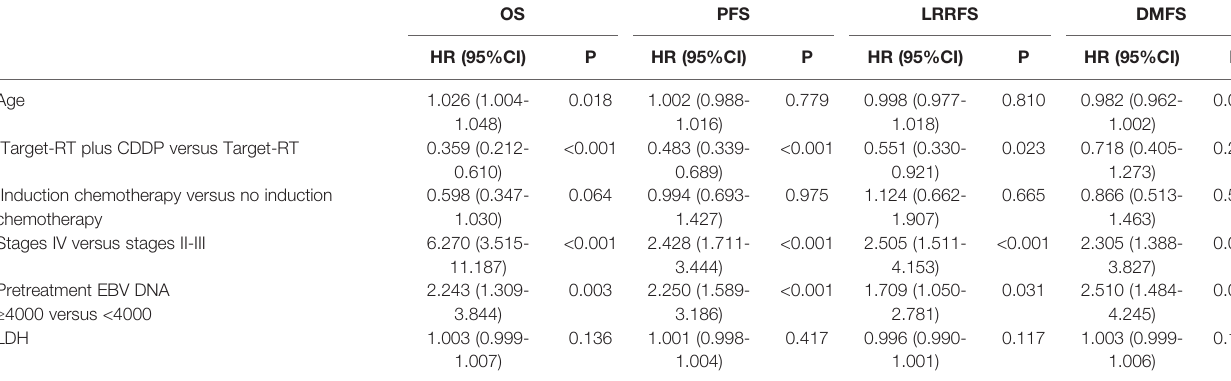
TABLE 2 | Multivariate analysis for long-term survival for the entire group of NPC patients treated with concurrent anti-EGFR agents.